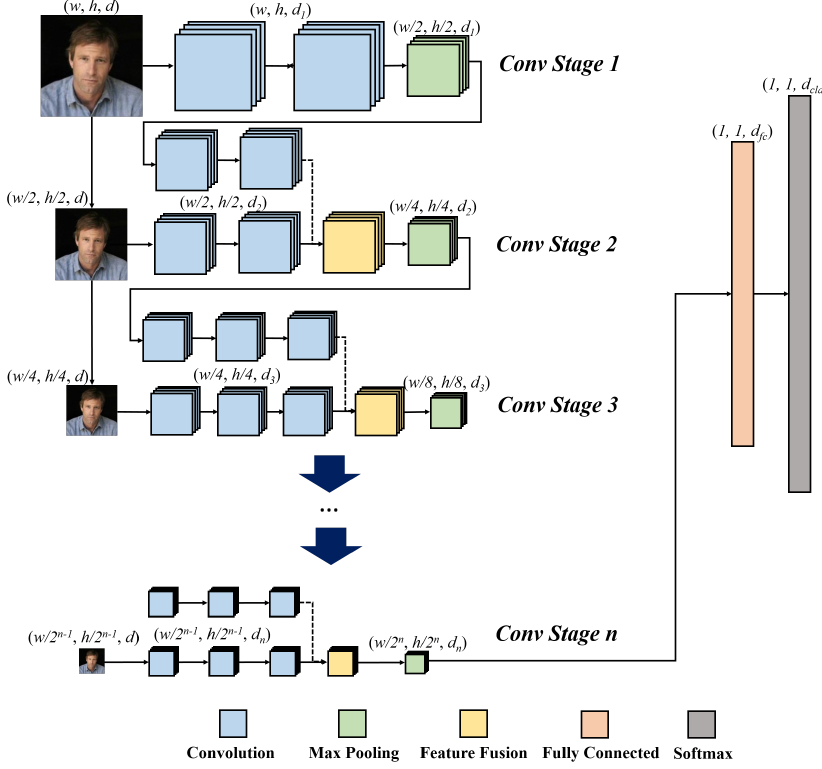
Figure 2. An overview of our PSI-CNN